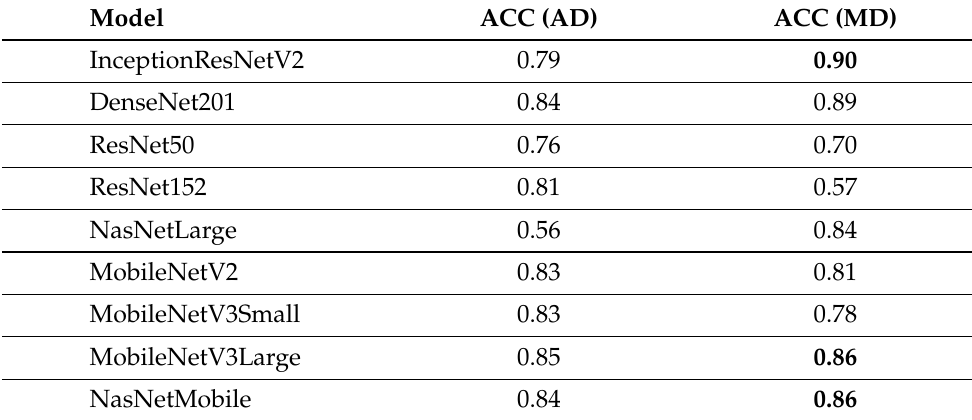
Table 5. Accuracy of all models. ACC stands for accuracy. AD stands for augmented data; this indicates that the model is trained with augmented data. MD stands for metadata, which indicates that the model is trained with metadata. The bold numbers highlight the highest performance. These results are calculated from the confusion matrix, the two highest model confusion matrices are DenseNet201 and InceptionResNetV2 (as shown in Figures 10 and